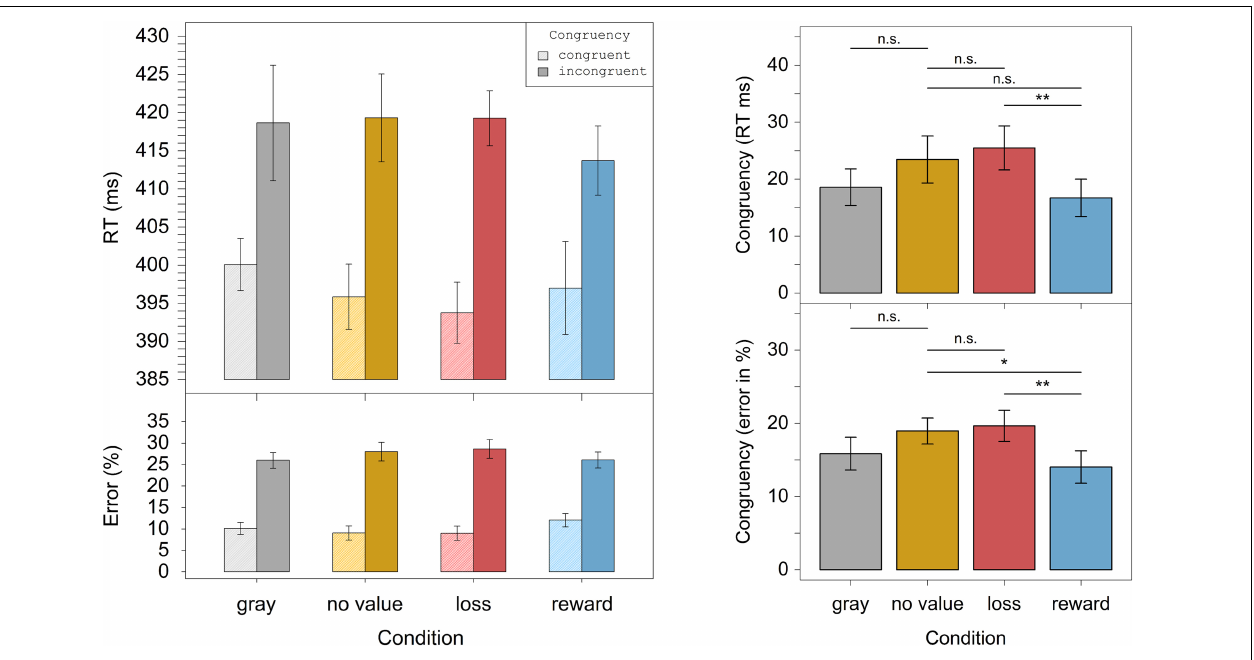
FIGURE 2 | Experiment 1. The left panel displays the RTs and error rates for the different congruency and distractor conditions. The right panel displays differences in the Simon congruency effects for respective pairs of distractor conditions. Displayed are only data from trials in which the deadline was met. Error bars correspond to the within-subject confidence intervals (Morey, 2008). *Significant on p < 0.05, **significant on p < 0.01, ***significant on p < 0.001, n.s. = not